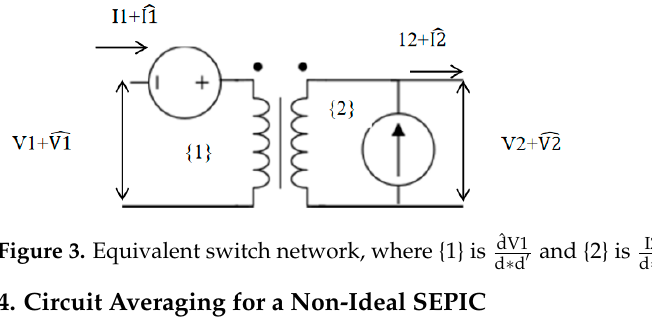
(cid:2893)(cid:2870)(cid:2914)(cid:3553) . (cid:2914)∗(cid:2914) (cid:4594)